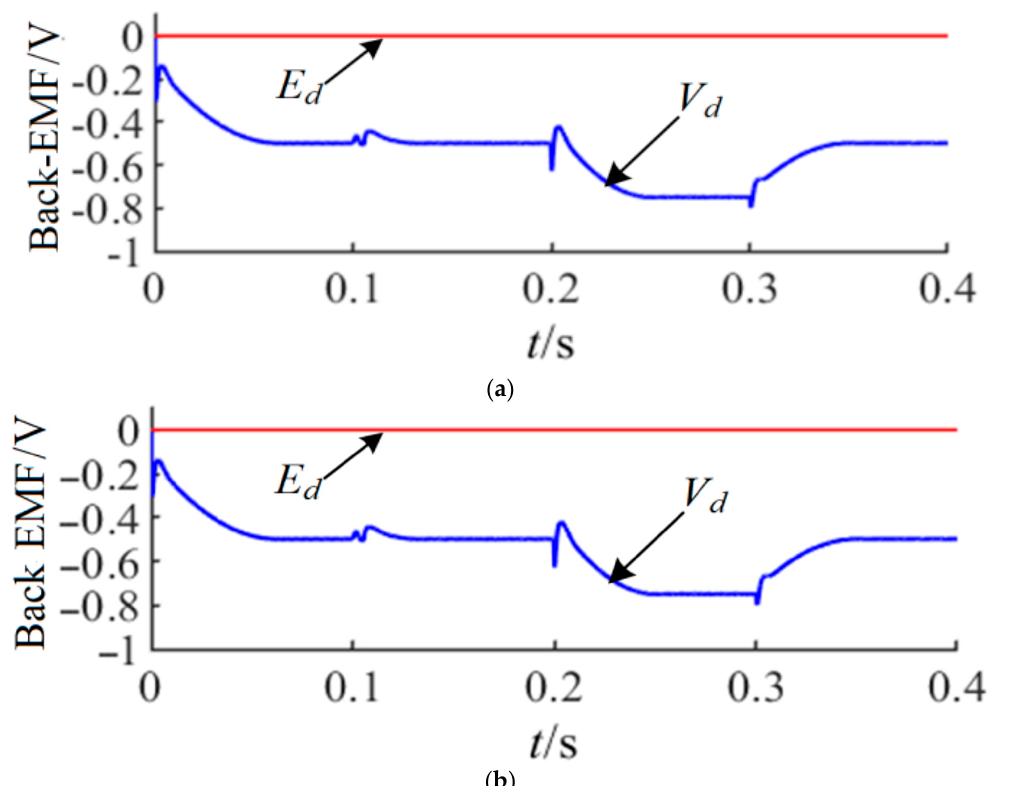
Figure 3. The d-q axis back EMF curve. ( a ) The d-axis back EMF curve. ( b ) The q-axis back EMF curve.